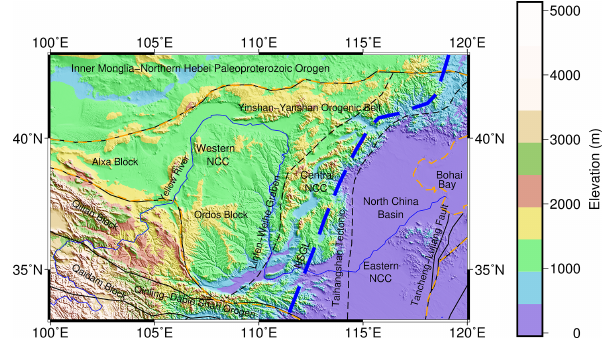
Figure 1. Topography and main tectonics of the study area. NCC – North China